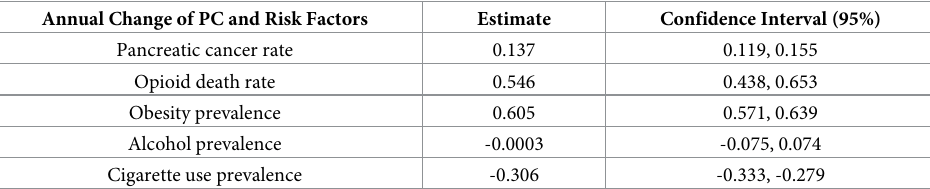
Table 1. Annual change of PC rate and risk